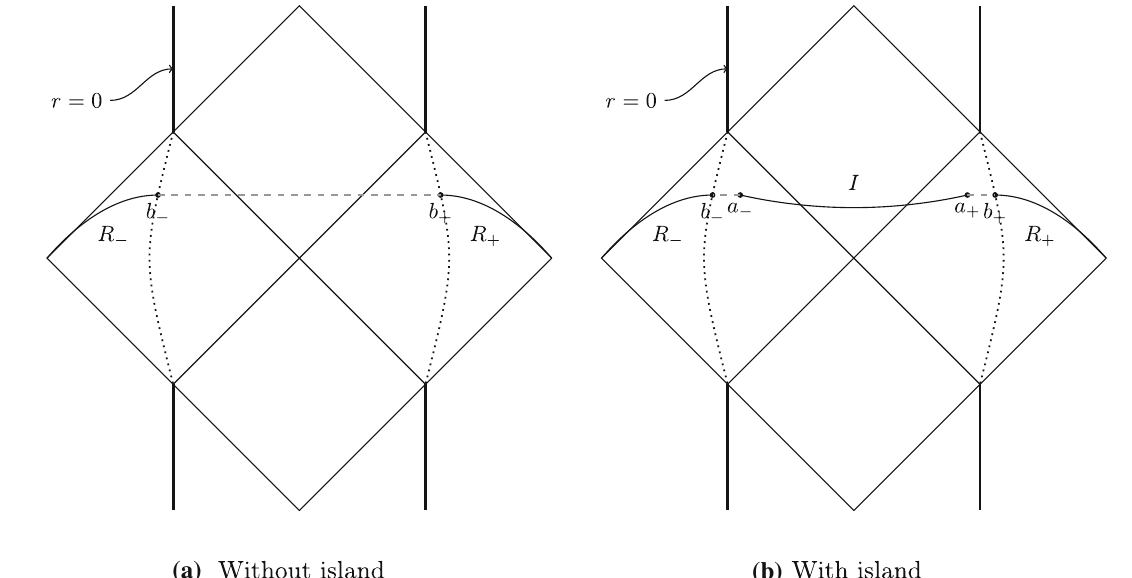
Fig. 1 The Penrose diagrams of an eternal non-extremal black hole are presented without an island (left) and with an island (right). The region for the Hawking radiation R is separated into two parts; R + and R − located in the right and left wedges, respectively. The boundaries